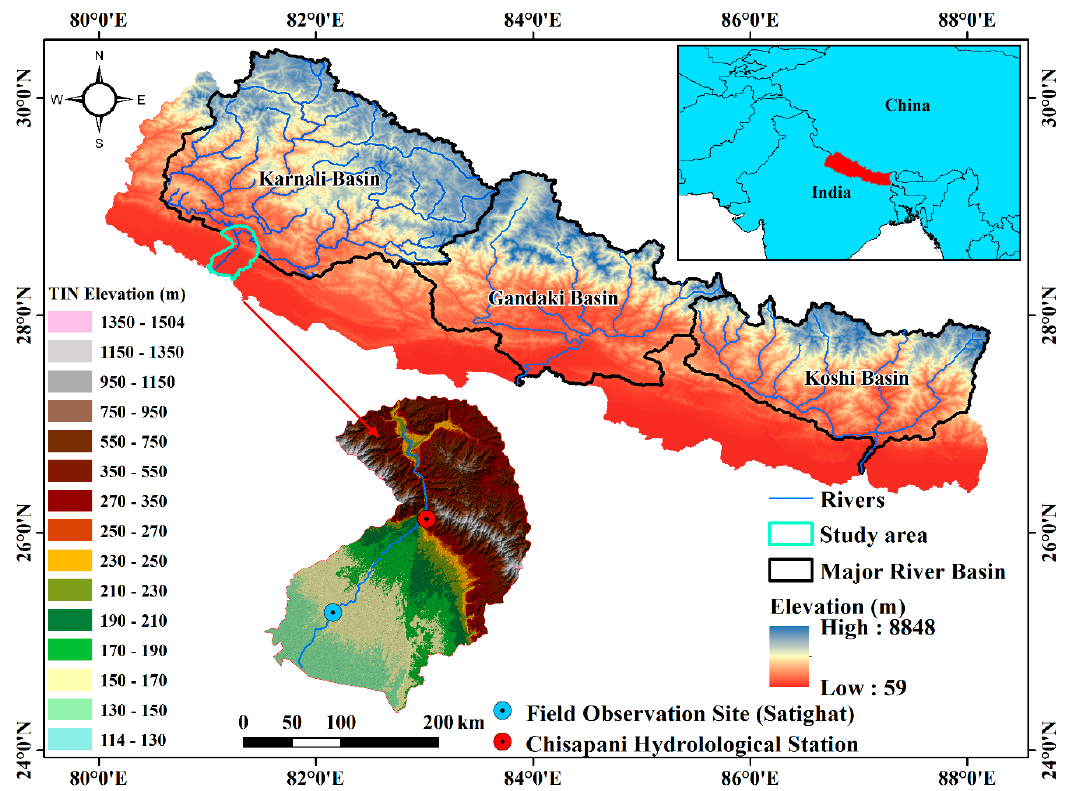
Figure 1. The study area and its elevation in Triangulated Irregular Network (TIN) form. The location of the study area in Nepal and the three major river basins is also provided for reference.